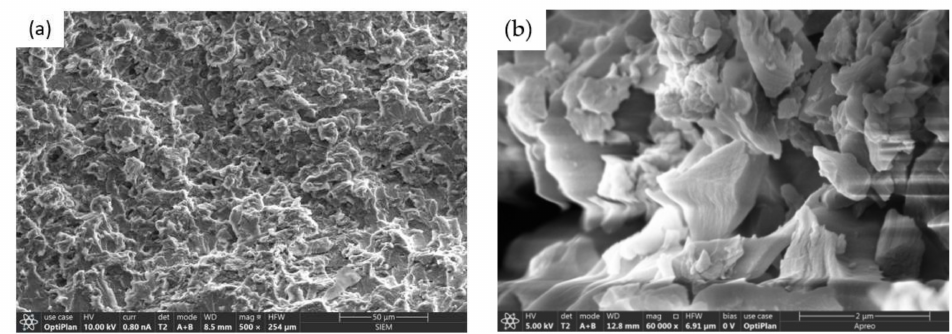
Figure 4. SEM images of GO/EP composites ( a ) GO/EP composites (500 × ), ( b ) GO sheets (60,000 ×